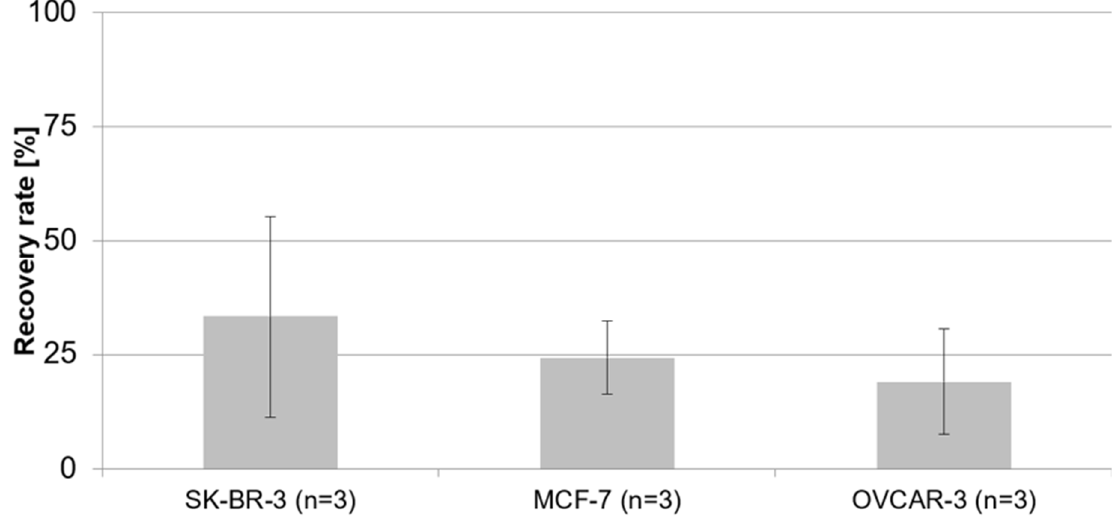
Figure A1. Recovery rates of different cell lines spiked into 10 mL of healthy donor blood, undergoing the enrichment procedure followed by single cell sorting using the DEPArray TM . For each sample, an approximate number of 40,000 cells was investigated (sample size was set by the loading capacity of one DEPArray TM cartridge), the Hoechst pos and CK pos detected cells were then extrapolated to the actual sample size.